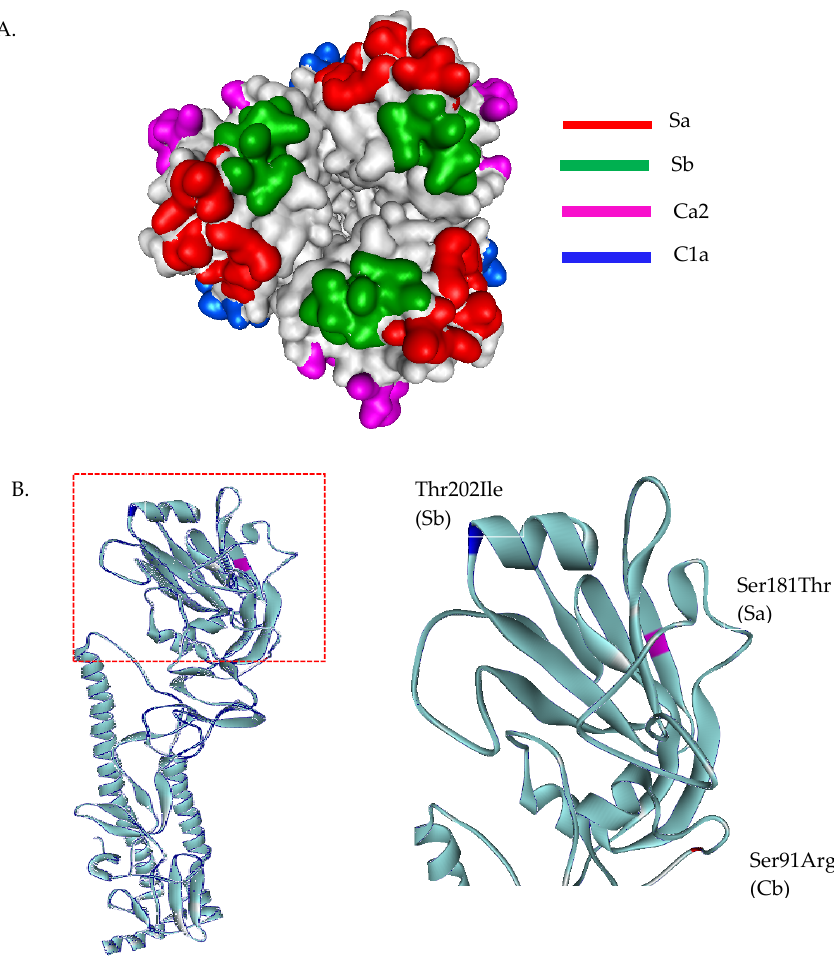
Figure 2. Three-dimensional structural analysis of A/H1N1 HA protein ( A ). Top view of head domain of H1N1 showing antigenic sites located in different regions of the HA molecule ( B ). Superimposed HA structures of A/Michigan/45/2015 (H1N1) and A/H1N1 Thai isolates, where mutations at antigenic sites are highlighted in blue, magenta, and red. HA structures were built based on the structure of A/California/07/2009(H1N1) HA protein, PDB ID: 3UBE